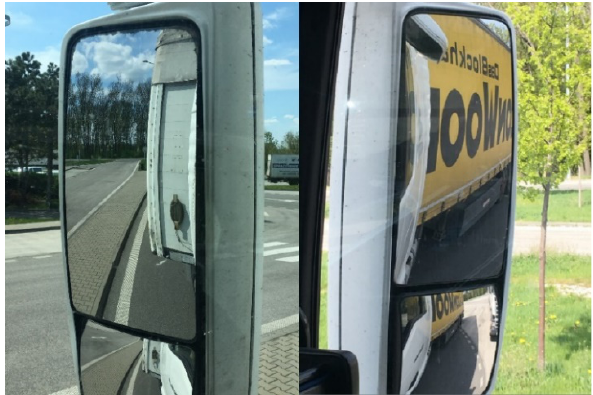
Figure 2. Right-hand cornering of semi-trailer.